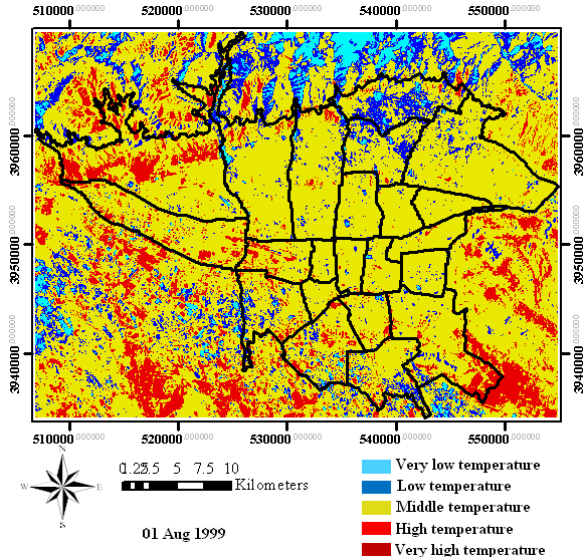
Figure 4. The map of Spatial Distribution Changes LST of the